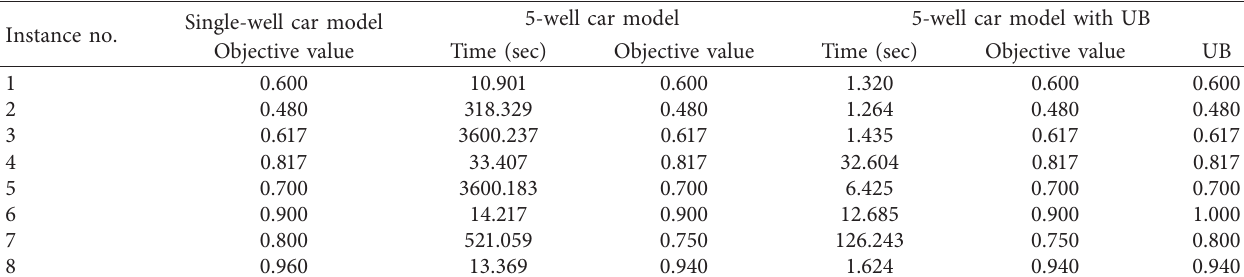
Table 3: Empirical results for N �